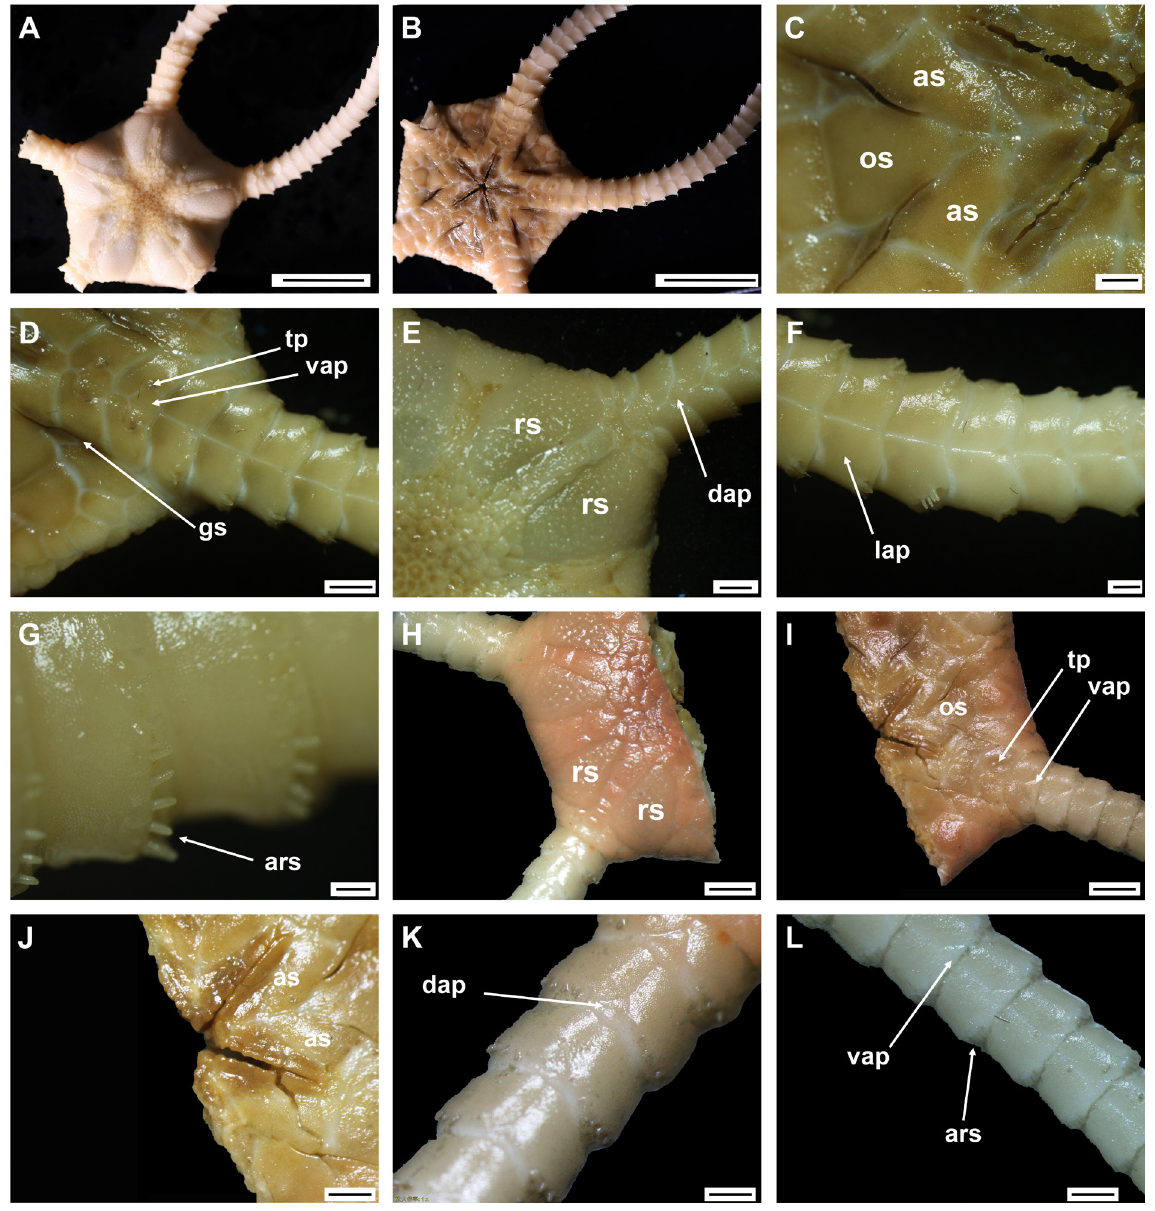
Fig. 13. A–G . Ophiomusa lymani (Wyville Thomson, 1873) (IDSSE EEB-SW0008). A . Dorsal disc. B . Ventral disc. C . Oral frame. D . Ventral arm base. E . Dorsal arm base. F . Ventral arm. G . Lateral arm plate with arm spines. H–L . Ophiomusa sp. (IDSSE EEB-SW0010). H . Dorsal disc. I–J . Ventral disc. K . Dorsal arm. L . Ventral arm. Abbreviations: as = adoral shield; ars = arm spine; dap = dorsal arm plate; gs = genital slit; lap =lateral arm plate; os = oral shield; rs = radial shield; tp = tentacle pore; vap = ventral arm plate. Scale bars: A = 10 mm; B = 15 mm; C–E = 2 mm; F, H–L = 1 mm; G = 500